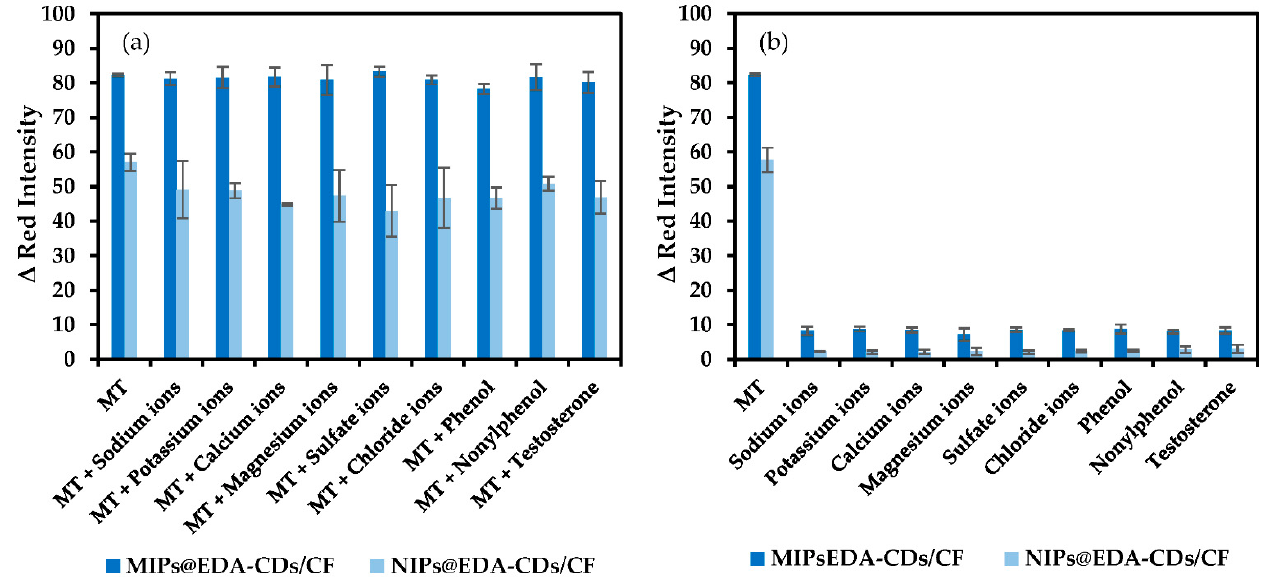
Figure 7. Effect of interferences on MT detection (500 μ g/L) in ( a ) the binary system and ( b ) the single system using the MIPs@EDA-CDs/CF and the NIPs@EDA-CDs/CF. The concentration of all interferences was 500 μ